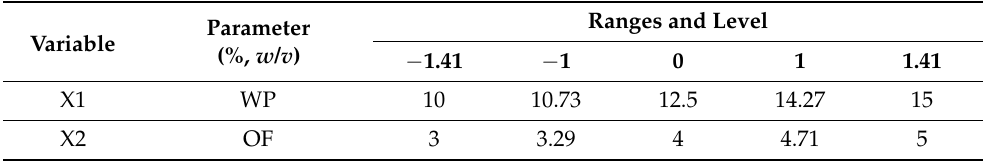
Table 1. Independent variables (whey permeates, WP; oat flour, OF) and their levels in the central composite